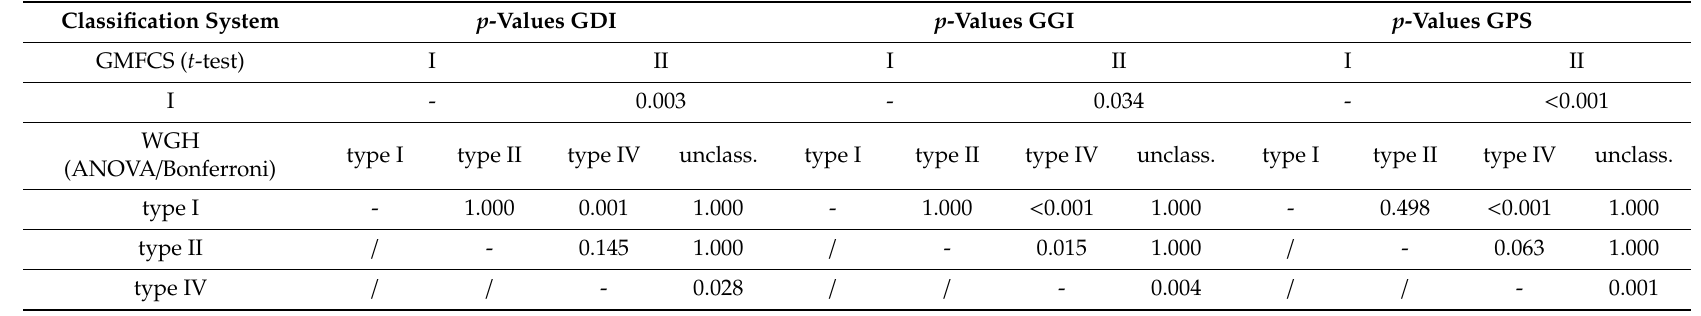
Table 2. Comparative statistics of the di ff erent gait indices between GMFCS levels and between WGH types. WGH: Winters, Gage, Hicks.